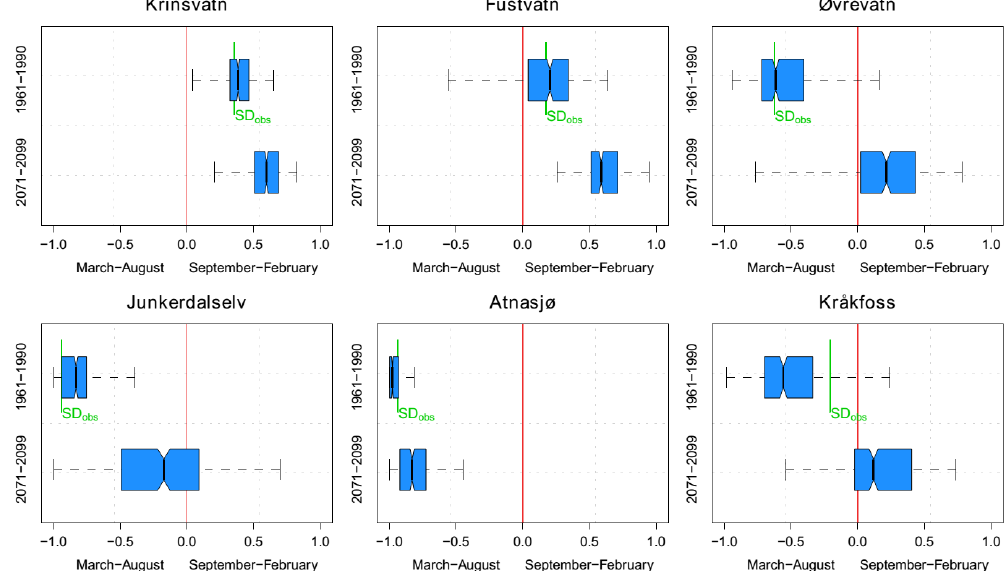
Figure 4. Boxplots showing the seasonality index S D for all ensemble realizations for the reference and future periods. The boxes show the interquartile of the values; the whiskers show the full range of the projections. The green bars in the upper panel of each plot ( S D the observed seasonality index S D